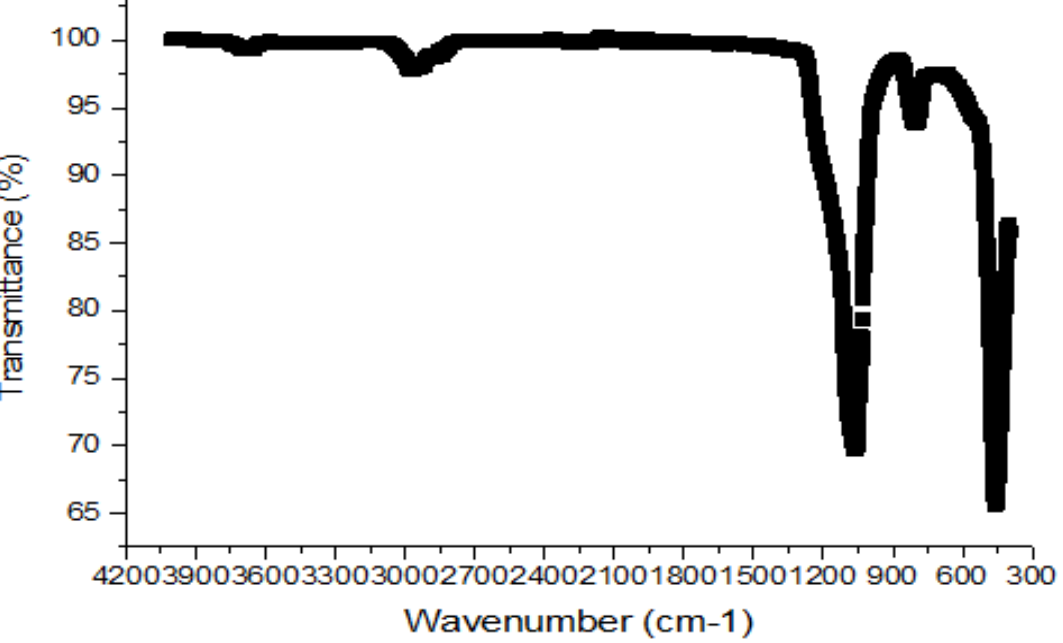
Figure 3. FTIR spectra of synthesized silica monolith particles.